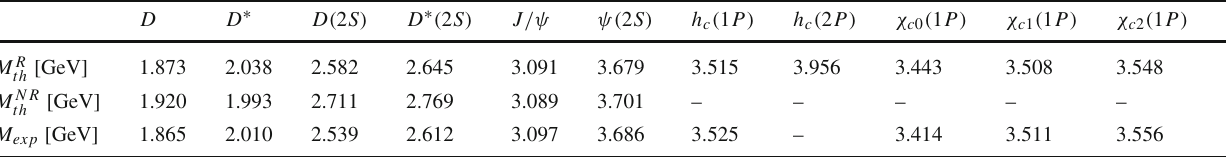
Table 7 Mass spectra of the charmed mesons. M R model [65], and in experiments [75], respectively